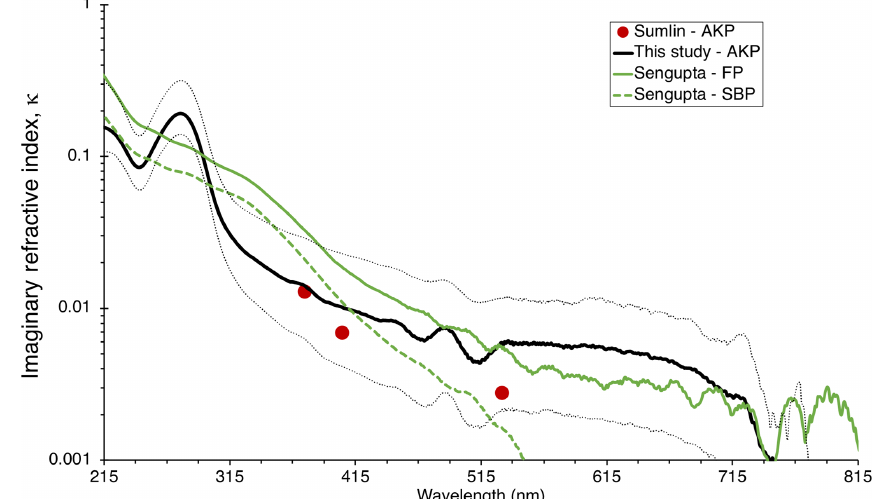
Figure 6. BrC imaginary refractive index, κ BrC , as estimated in this study and compared to values from other selected studies: Siberian peat (unpublished data) and Florida peat – SBP and FP, respectively – from Sengupta et al. (2018), and Alaskan peat (AKP) from this study and Sumlin et al. (2018b). The thin, dotted black lines indicate the upper and lower bounds of κ BrC retrievals for this